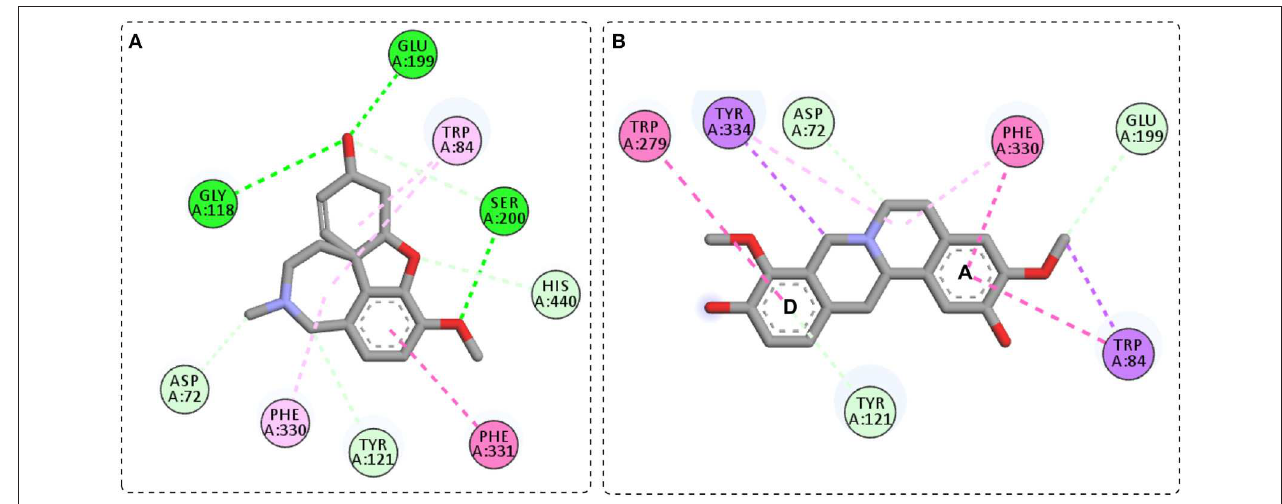
presented π -cation and attractive charge interactions with Asp72 and Tyr334, respectively. Surprisingly, no relevant interaction was observed for the benzyl